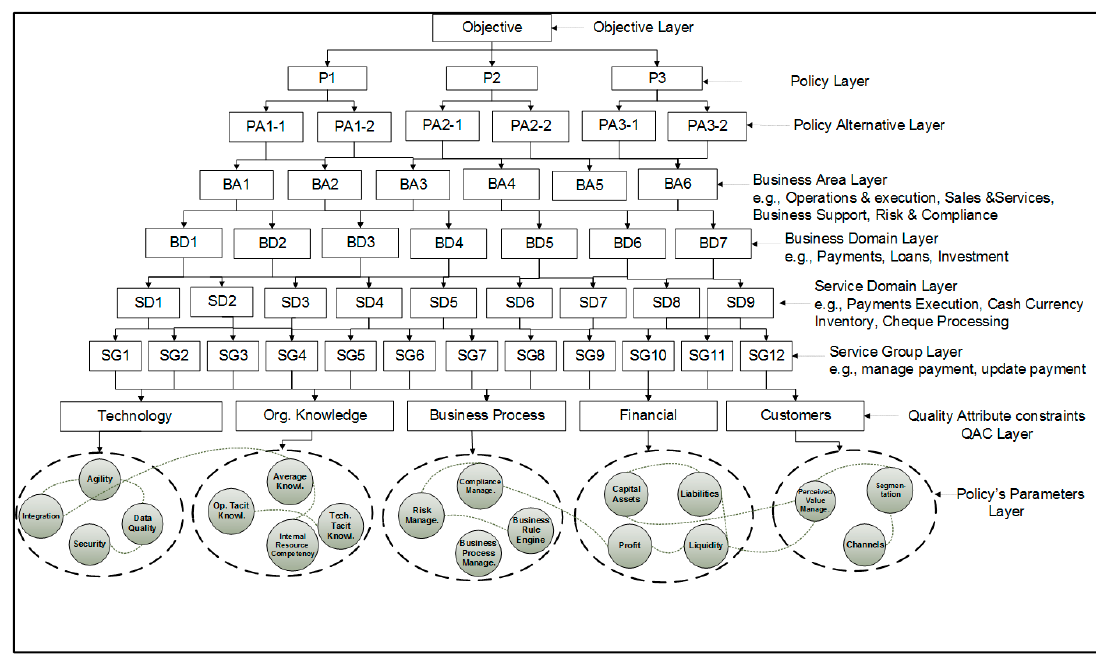
Figure 2. Computational regulatory policy change governance framework.